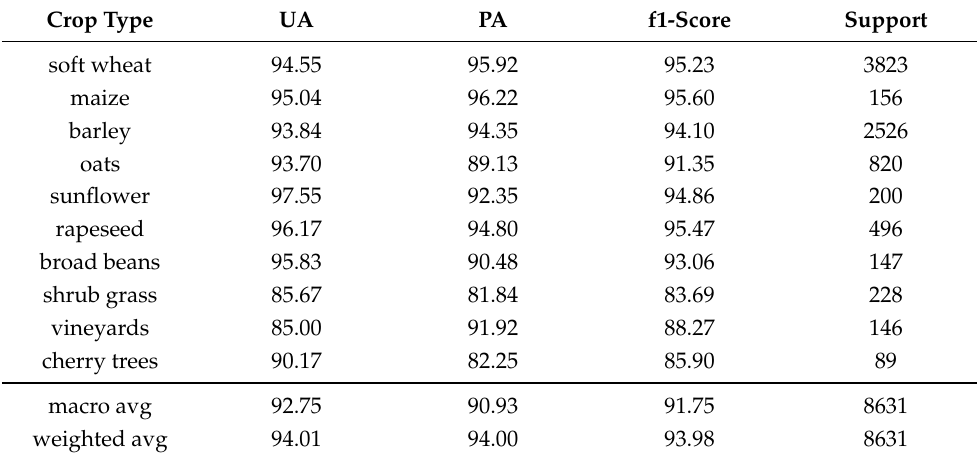
Table 4. Classification report of SVM with 111 features derived when used 15 as